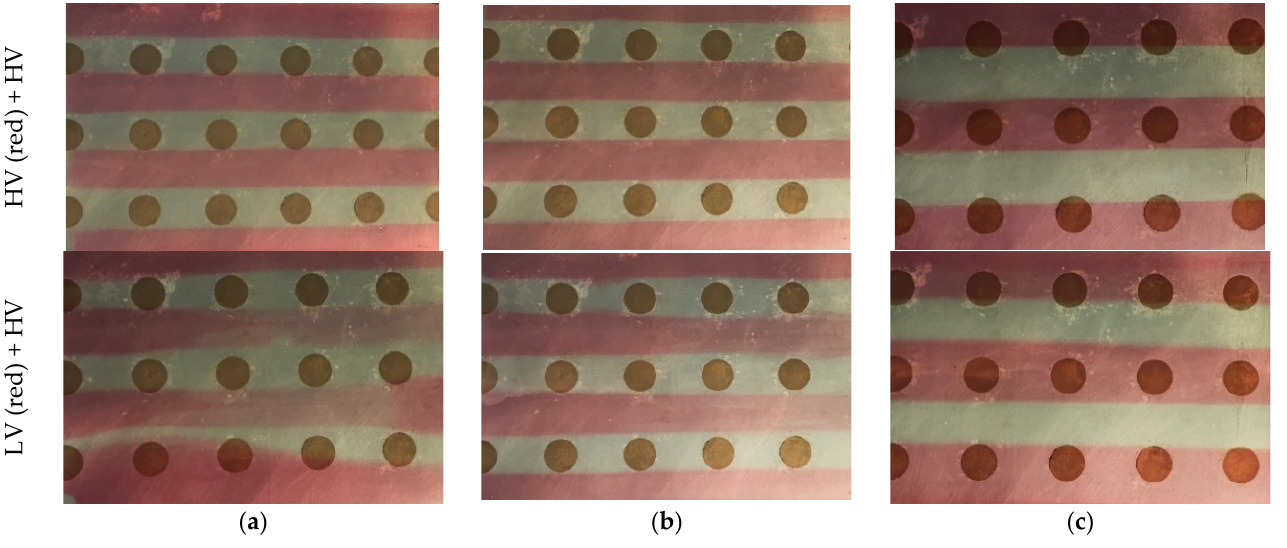
Figure 4. Photographies of the placebo tandem films cast of higher viscous (HV) and lower viscous (LV) HPMC solutions with the three insert models. The visible circles are for vacuum extraction.